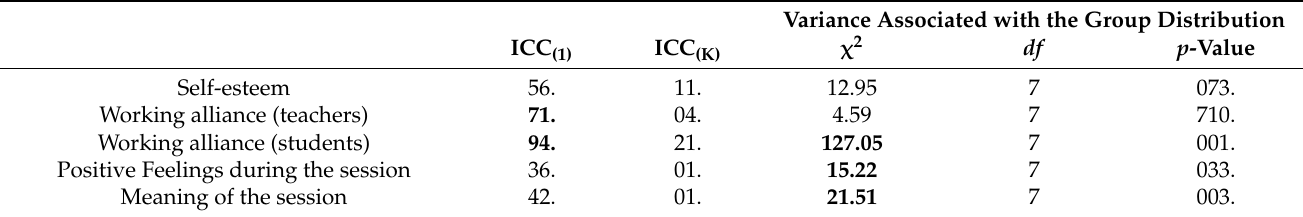
Table 2. ICC test results and the significance of the variance associated with the groups for the main research indices. Variance Associated with the Group Distribution ICC (1) ICC (K) χ 2 df p -Value 56.